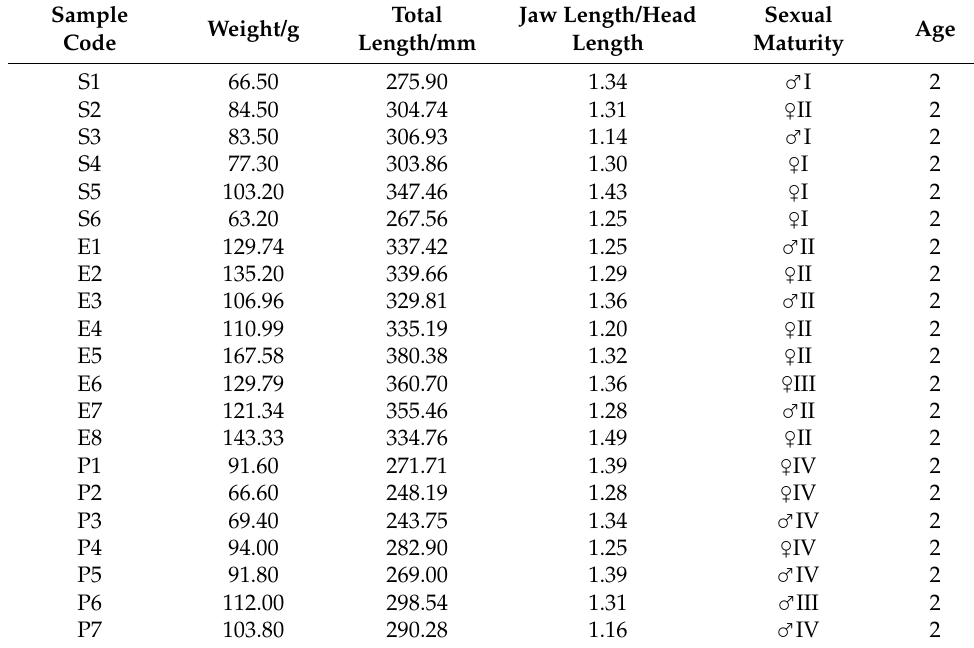
Table 2. Basic information of C. nasus in different water